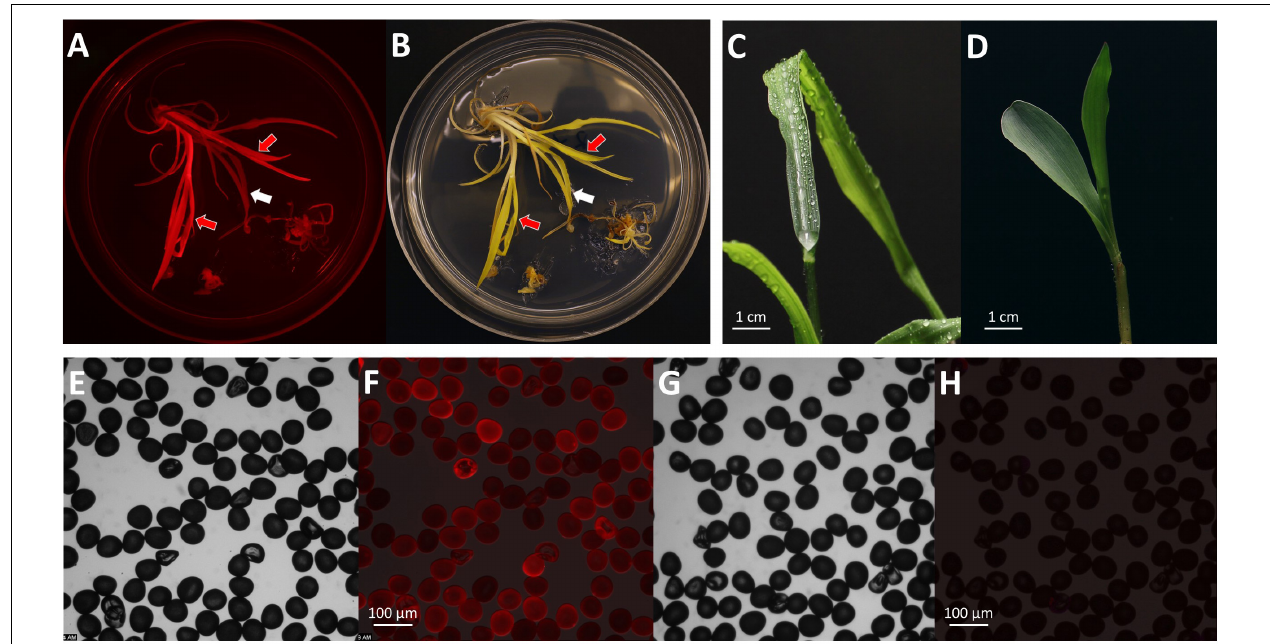
FIGURE 6 | Phenotypes of T0 transgenic plants. Observation of mature shoots with roots on the maturation II medium under an RFP channel (A) and a bright field (B) . Black arrow indicates a shoot with RFP expression; white arrow indicates a shoot without RFP expression. Observation of the gl2 knock-out phenotype on a T0 regenerated plant (C) and a wild-type seedling after water spray (D) . Observations of pollen grains collected from a T0 plant (E,F) and a wild-type B104 control (G,H) . Images of (E,G) , bright field; (F,H) , RFP field overlay.